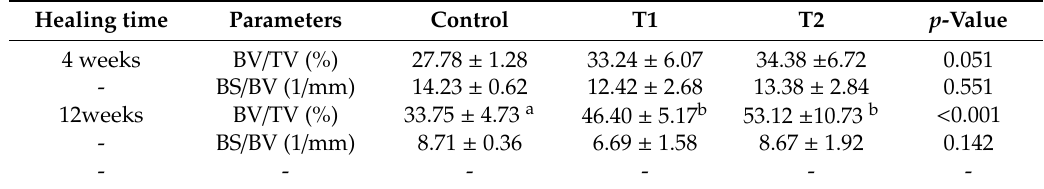
Table 1. Results of qualitative micro- computed tomography (CT) analyses at 4 and 12 weeks of healing. Healing time